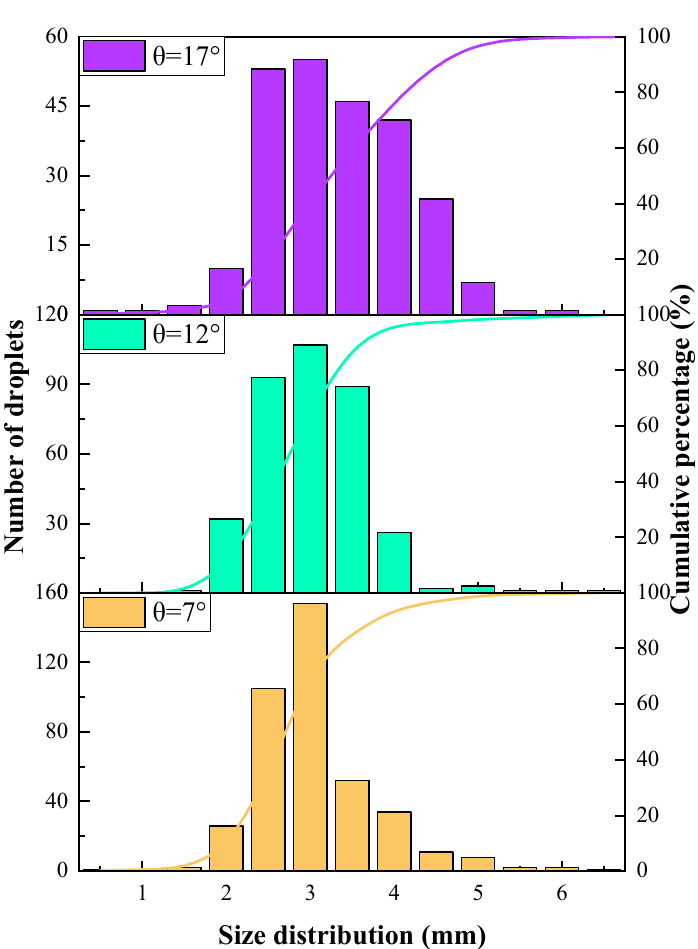
Figure 4. Size distributions of droplets in the emulsified region against injection angles.